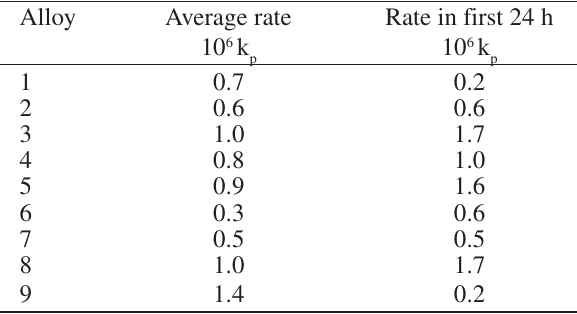
Table 1. Alloy compositions (at. pct.) and phase constitutions (volume fraction). Table 2. Parabolic rate constant (mg 2 /cm 4 S -1 ) for isothermal oxi-